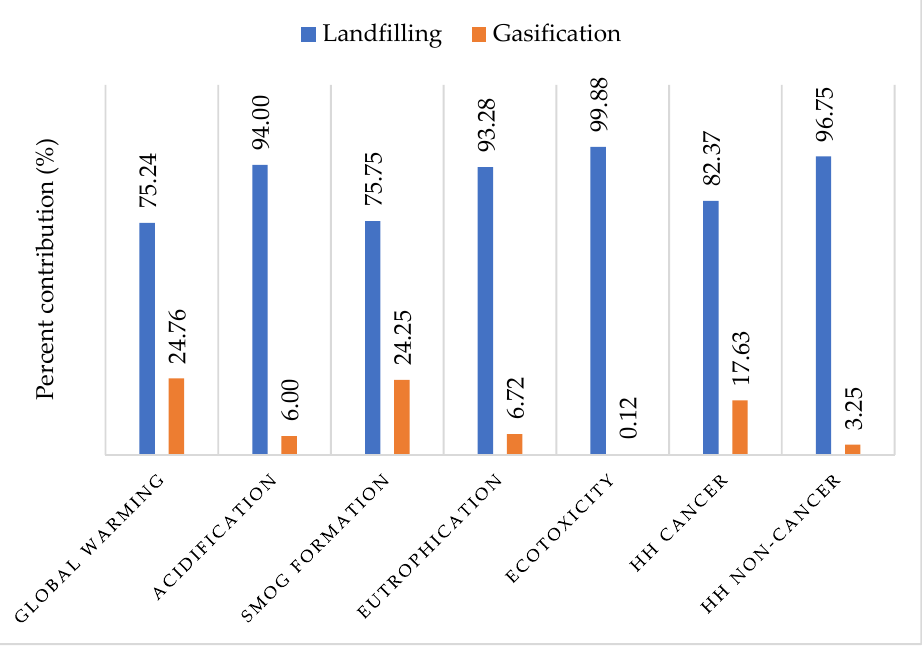
Figure 4. Comparative impact assessment of MSW gasification and landfilling.